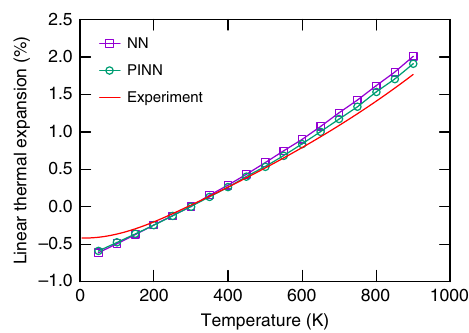
Fig. 3 Linear thermal expansion of Al relative to room temperature (295 K) predicted by the PINN and NN potentials in comparison with experiment